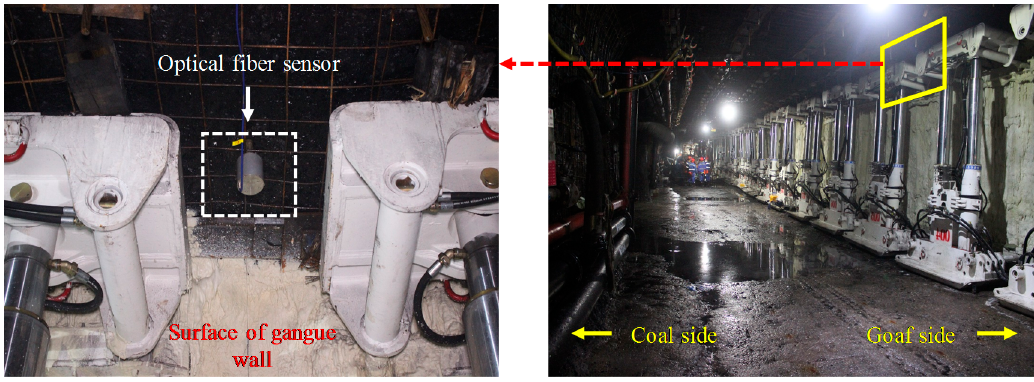
Figure 15. Installation of optical fiber sensors.